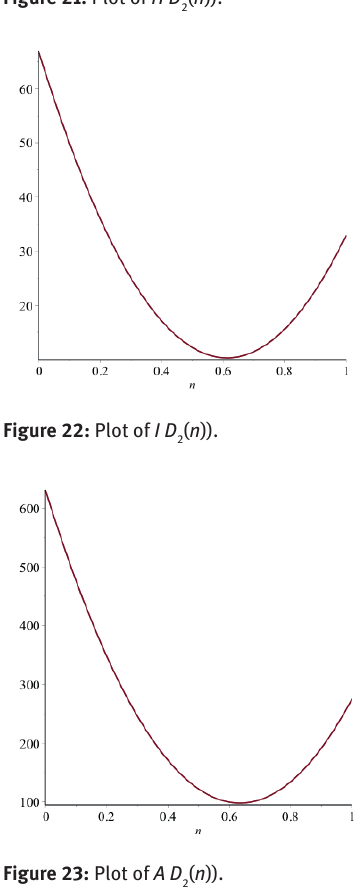
Figure 21: Plot of H D